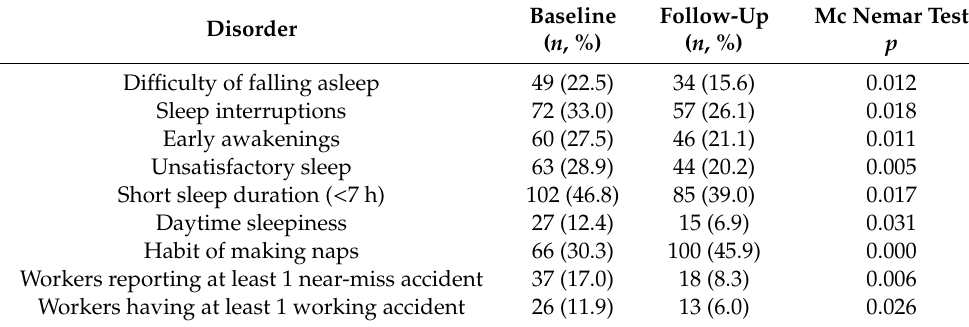
Comparison of the prevalence of sleep problems, habit of taking naps, accidents, and near-misses at baseline and at the end of the follow-up (whole